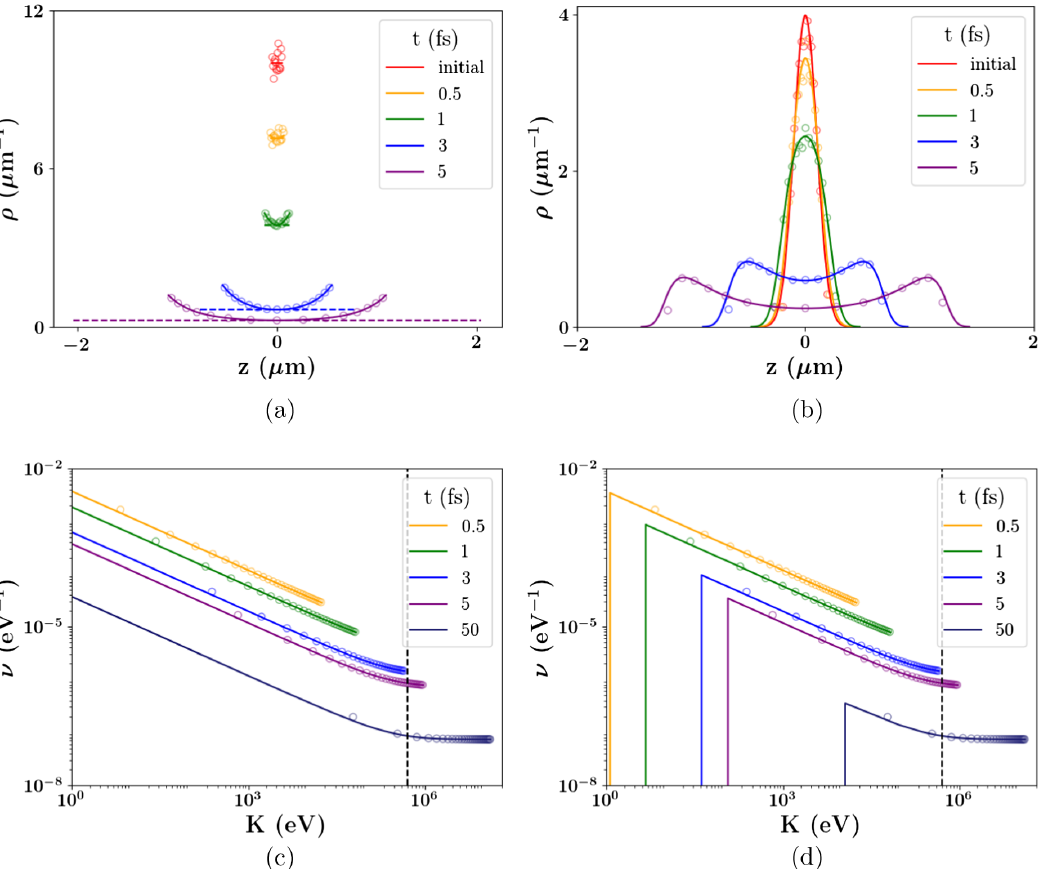
FIG. 3. Theoretical predictions (solid line) and M -shell simulations (hollow dots) of the (a,b) spatial and (c,d) energy densities at (a,b) 4 and (c,d) 5 different times with either (a,c) uniform or (b,d) Gaussian initial spatial distributions. Simulations were accomplished by randomly sampling M macroparticles and advancing them according to the relativistic position equations derived in the text. Notice the log-log scale in the energy plots, and the initial energy densities in (c,d) are not shown as they are delta functions at K ¼ 0 . The 0 . 1 μ m, Q 10 8 electrons per μ m 2 , and M ¼ 10 000 . The extremely high simulation had either (a,c) L ¼ 0 . 1 μ m or (b,d) σ L ¼ tot ; 1 ¼ density was chosen as this density does not require significant expansion of the bunch before the onset of relativistic effects. The dotted lines in (a) represents the nonrelativistic prediction of the uniform distribution, and the purple dotted line extends beyond the ends of the x -axis but are not shown to keep the scale of expansion closer to what is seen relativistically; notice that the dotted line is tangent to the relativistic distribution at the same time at z ¼ 0 . The deviation of the theory above the dotted line and toward the center of the bunch indicates density freezing due to electrons obtaining luminal speeds whereas the nonrelativistic particles become superluminal. The vertical dashed lines in (c,d) correspond to the rest energy of an electron. Notice that far below this line, the energy density has one slope, but near this line, the energy density transitions to slope of